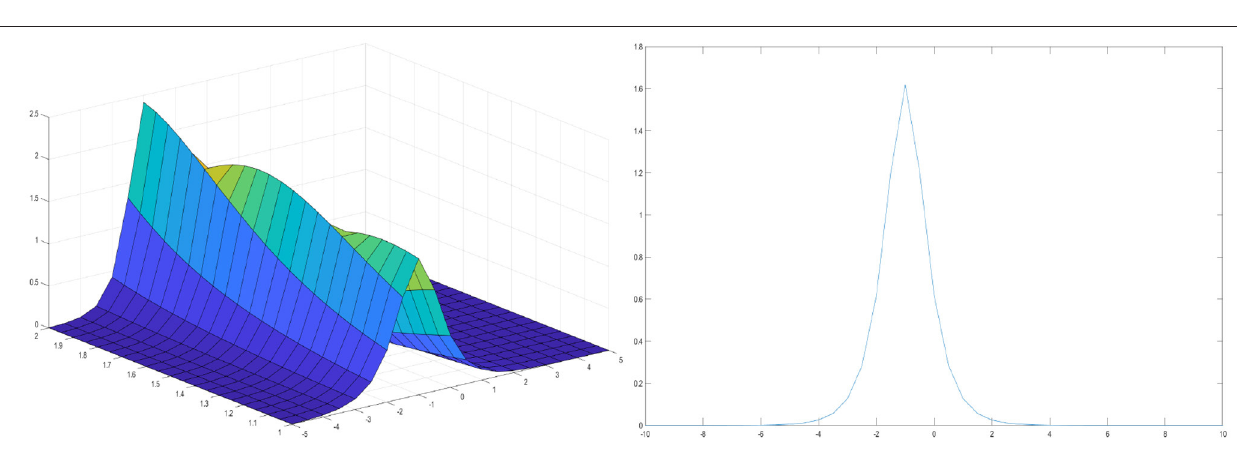
t 1, α 0.5, p 1, and γ ( t ) = = − = = −